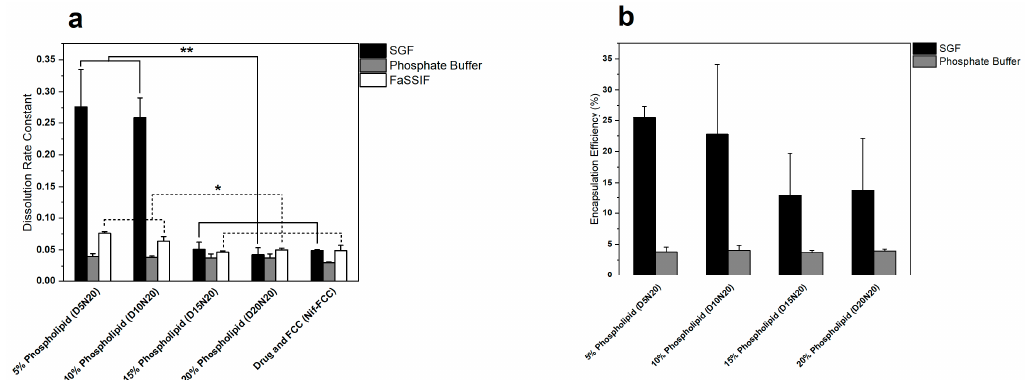
Figure 2. Comparison of the dissolution rate and liposomal encapsulation efficiency of nifedipine for different formulations. ( a ) The dissolution rate of formulations obtained from fitting the dissolution data to Equation (5), and ( b ) encapsulation efficiency of the liposomes after the hydration of powders in different media. Increasing the phospholipid content inversely affected both the dissolution rate and encapsulation efficiency. Single asterisk indicates a p -value < 0.05 and the double asterisk indicates a p -value < 0.005.